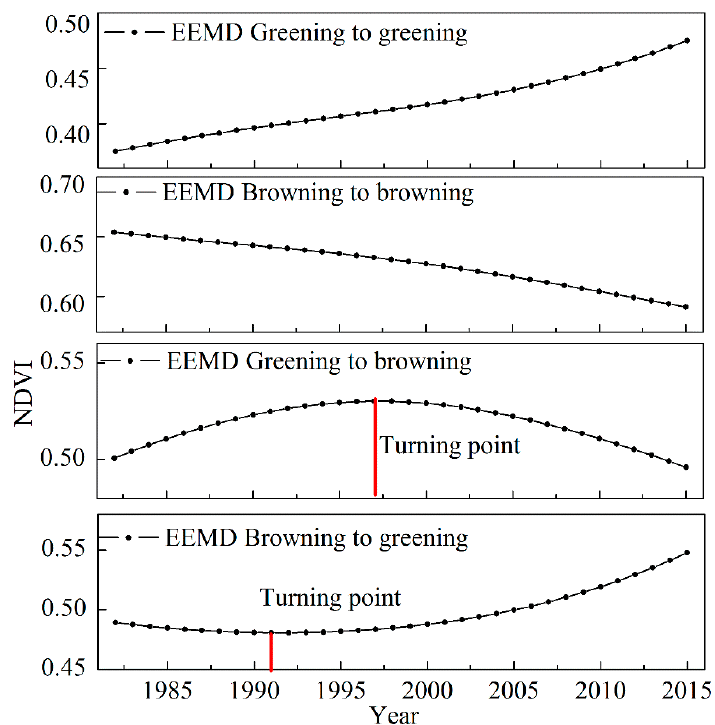
Figure 5. Temporal normalized di ff erence vegetation index (NDVI) classified by the EEMD technique.